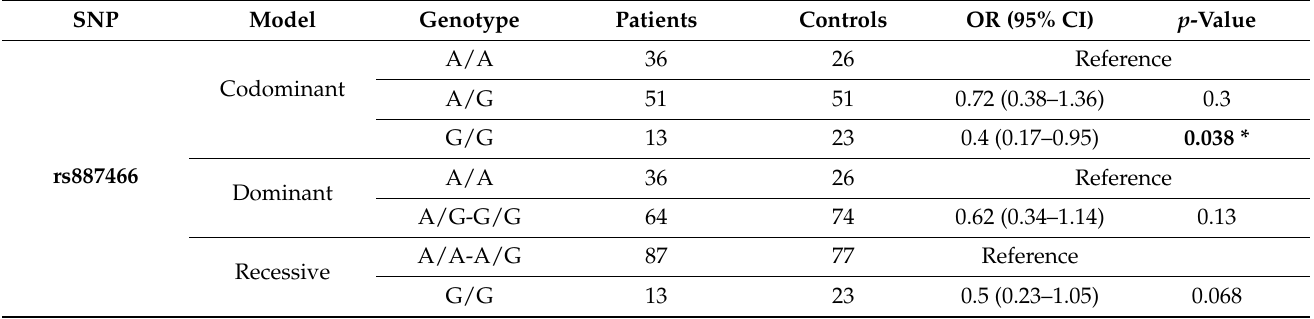
Table 4. Genetic Association Models for PSORS1C3 Gene Polymorphism with Disease Figure 3. Allele frequencies of PSORS1C3 gene rs887466, rs1062470 and rs10484554 in 1000Genome